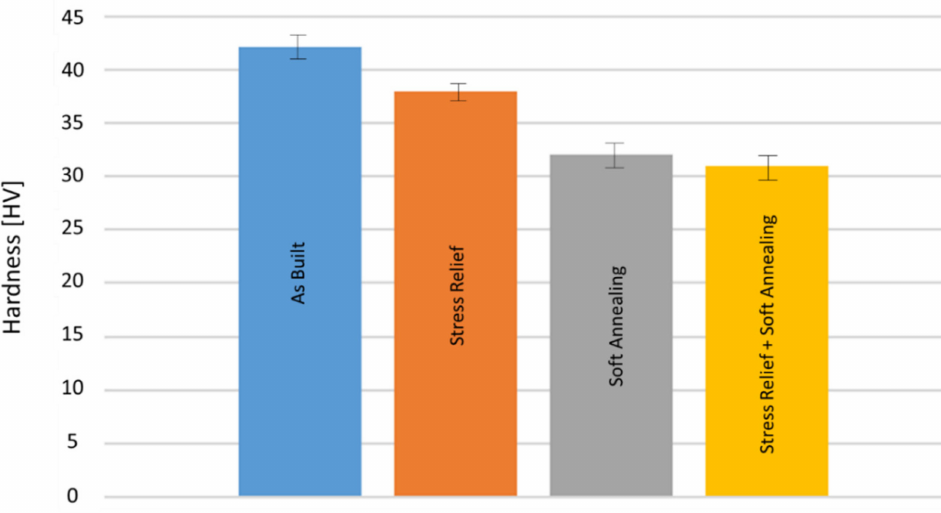
Figure 9. Vickers Hardness of as built and heat treated Cu